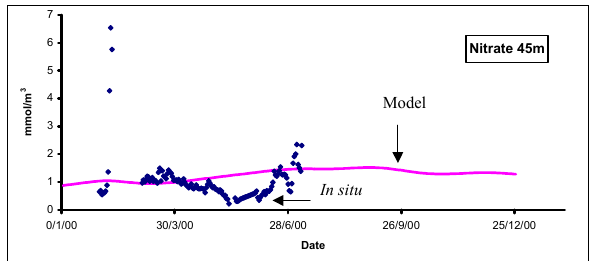
Fig. 7. Validation of model nitrate concentration at 45m, compari- son of nitrate concentrations from nitrate analyzer and in situ mea- surements during maintenance